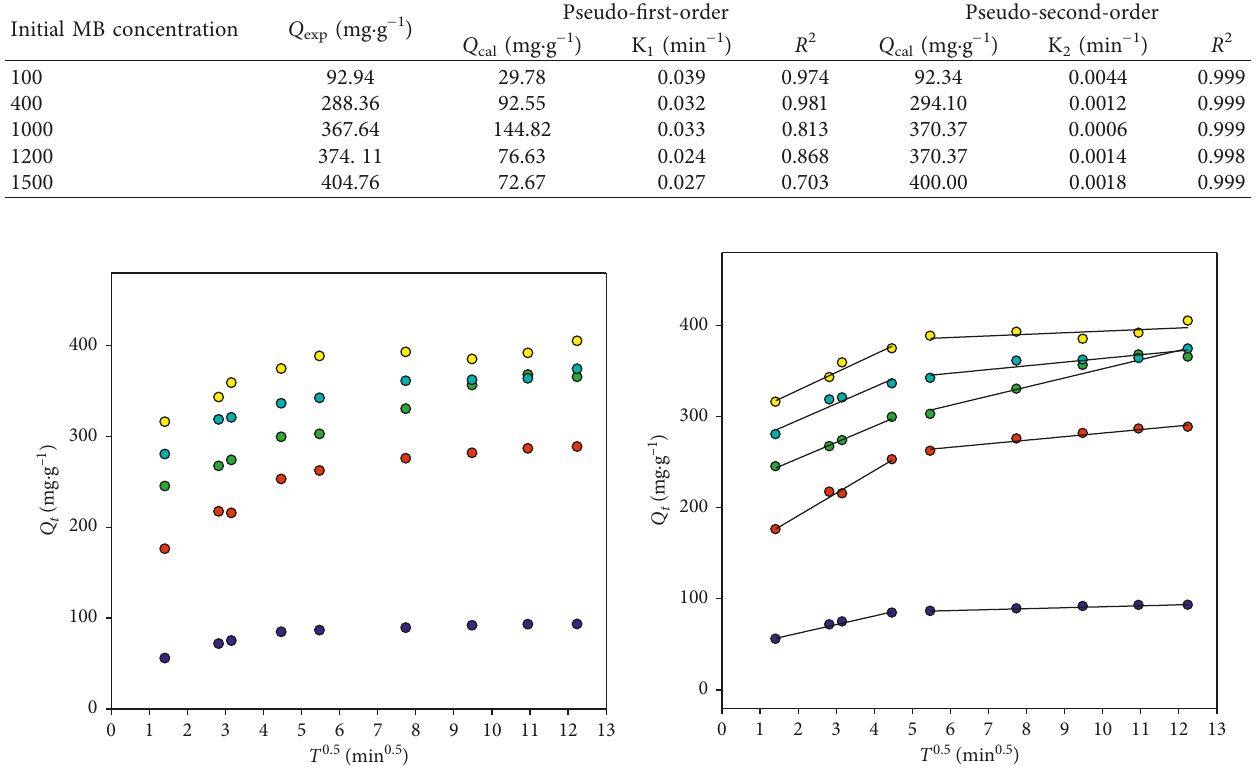
Table 3: Adsorption kinetic fitting results for the MB adsorption onto wasted tea